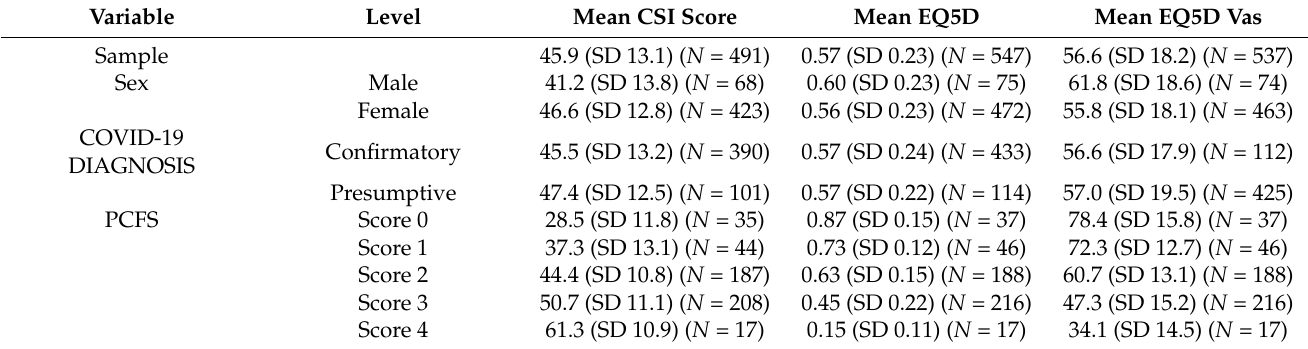
Table 1. Total scores on the CSI, separated for categorical variables. Abbreviations. N: number of respondents; PCFS: Post-COVID-19 Functional Status Scale, SD: standard